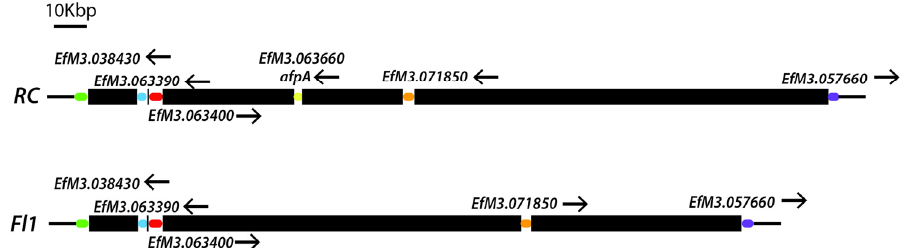
Figure 6. Diagrams from the E. festucae Rose City (RC) isolate contig 2 region containing Efe-afpA and the corresponding region from E. festucae Fl1 isolate chromosome 1 (GenBank accession CP031385.1). Corresponding genes from the two isolates are indicated with the same colors and arrows indicate the directions of the coding sequences. The black bars indicate the AT-rich repeated sequences between genes.